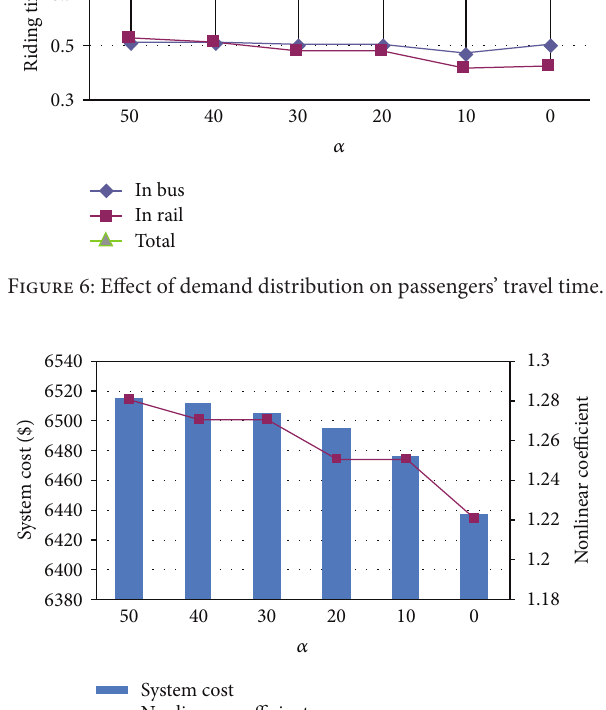
Figure 5: Effect of termination passengers on feeder passengers at stations.